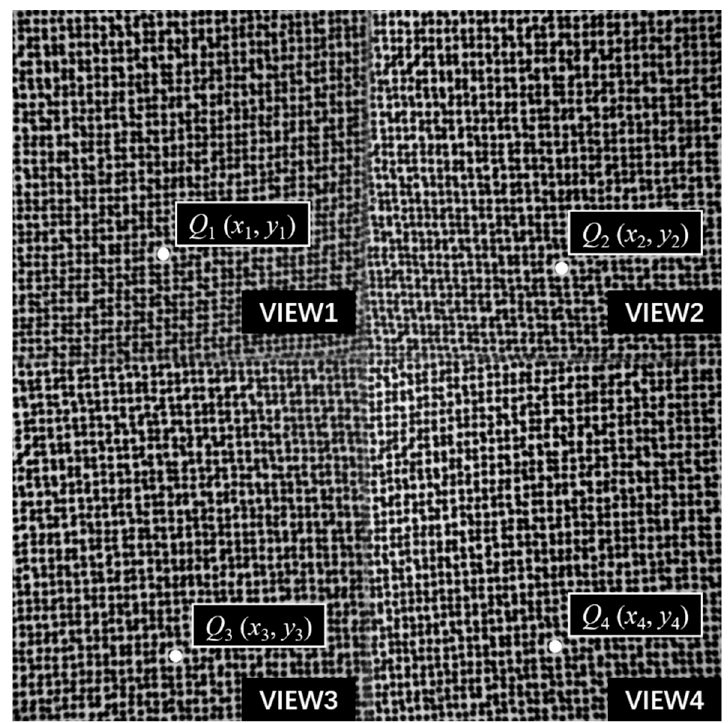
Figure 2. Speckle image of the specimen from four